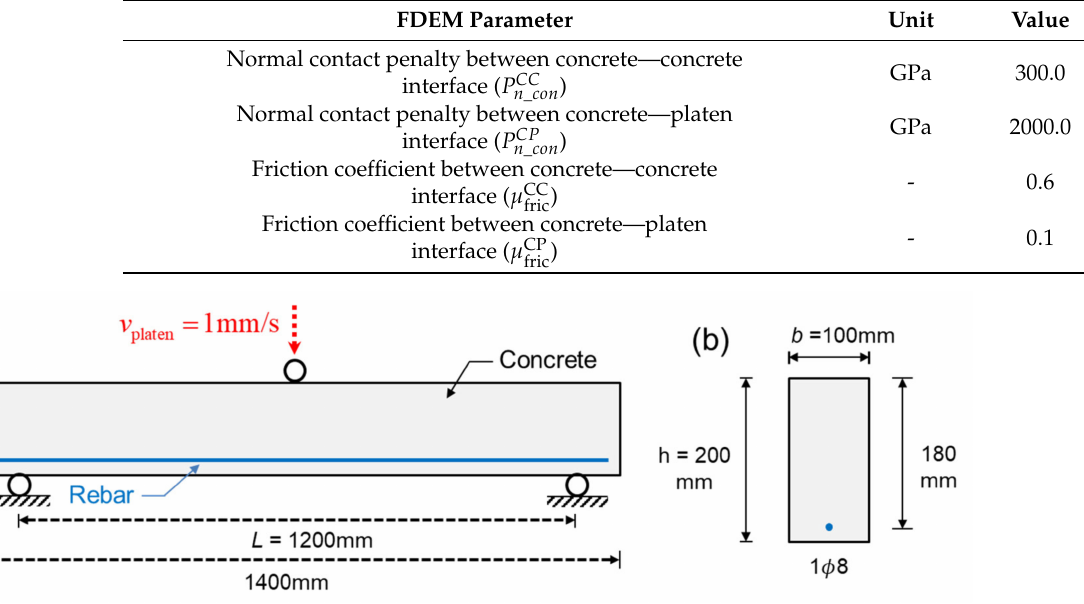
Table 3. Calibrating FDEM input parameters for modeling contact behavior in concrete structure [33].